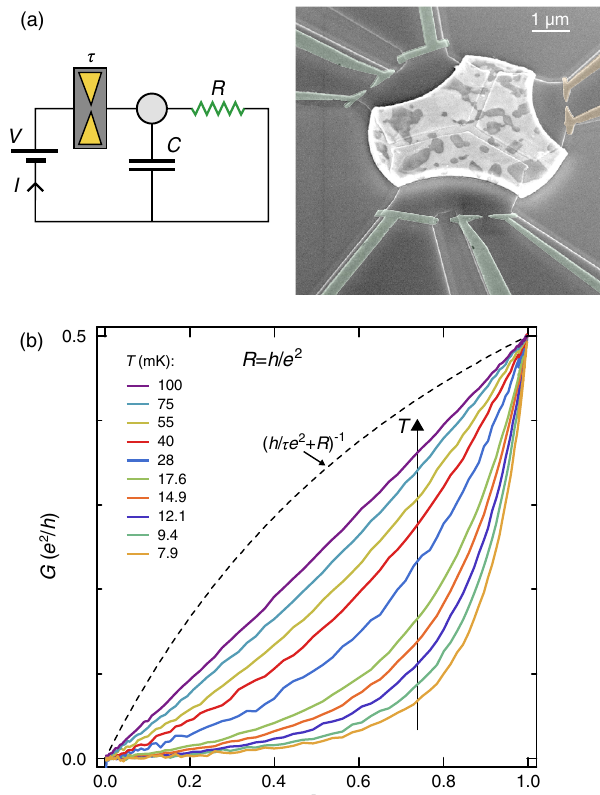
FIG. 1. TLL quantum simulator and quantum phase transition between metallic and insulating states. (a) The device ’ s schematic circuit (left) and colorized e -beam micrograph (right). A QPC set to a single electronic channel of bare transmission probability τ is formed in a 2DEG with the split gates colored yellow. The gates colored in green control the series resistance R and, thereby, the Luttinger interaction parameter K ¼ 1 = ð 1 þ Re 2 =h Þ . A bright metallic island on top of Y -shaped trenches separates the electronic channel and resistance. (b) Colored continuous lines display the device ’ s conductance G ¼ dI=dV measured at zero bias ( V ¼ 0 ) for different temperatures T in the presence of a series resistance adjusted to R ¼ h=e 2 ( K ¼ 1 = 2 ). The data are plotted versus bare (unrenormalized) τ , which is determined from G ð V ¼ 60 μ V ;T ¼ 7 . 9 mK Þ¼ð h= τ e 2 þ R Þ − 1 (black dashed line). The conductance vanishes upon cooling, except at the ballistic quantum-critical point τ ¼ 1